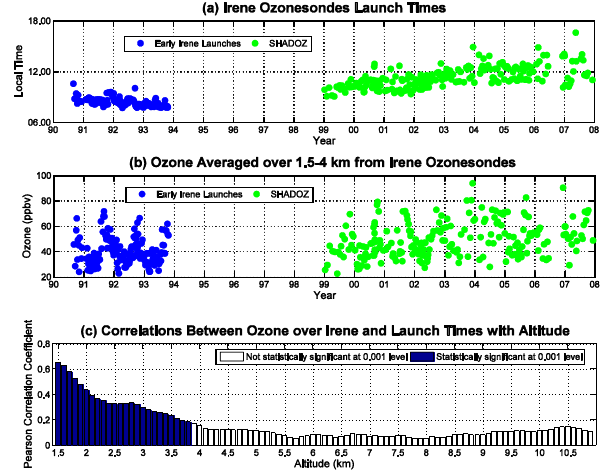
Figure 3. (a) Ozone mixing ratio, averaged over 4–15km, from the Réunion sonde record that started in 1992. (b) Corresponding data frequency of profiles used in (a) by month.